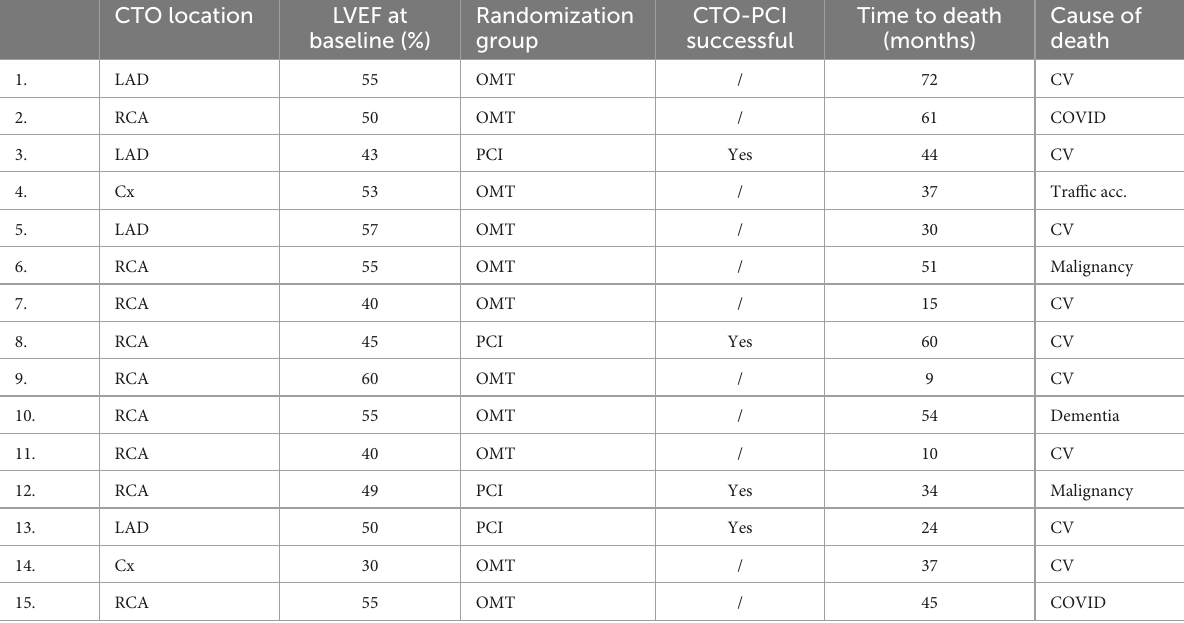
TABLE 3 Deceased patients and their